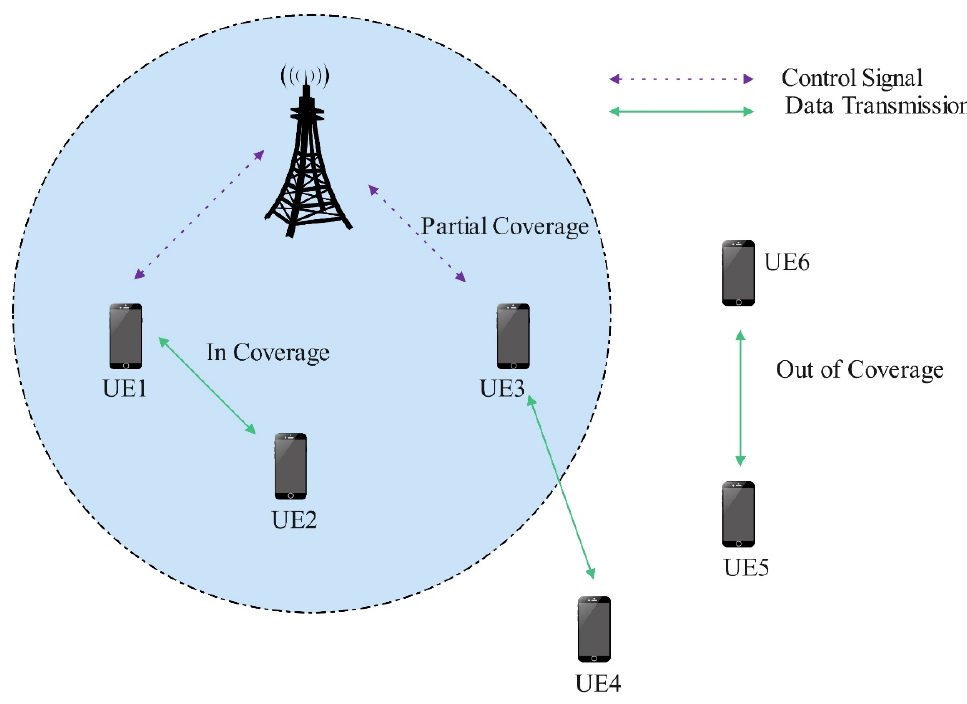
Figure 8. The scenarios of D2D communication supported in 3GPP Release